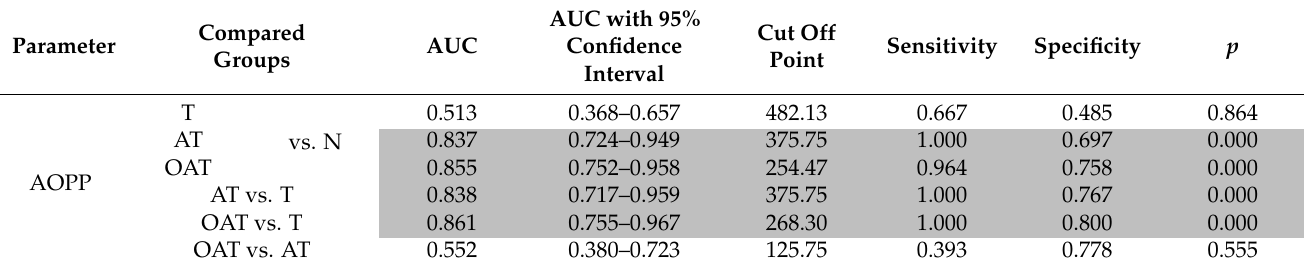
Table 3. Summary of receiver operating characteristic (ROC) curves analysis for seminal plasma